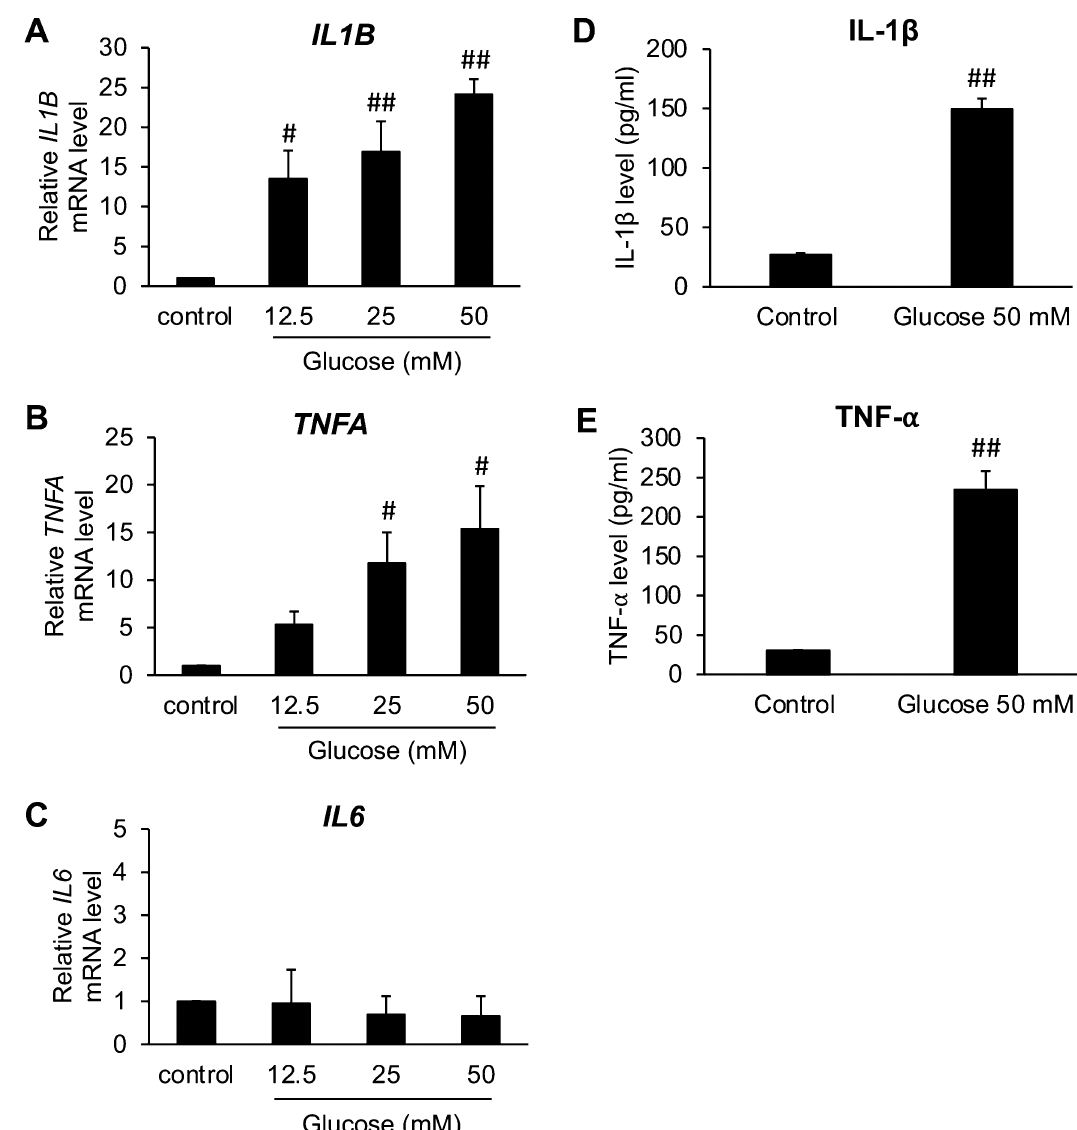
Figure 2. Effects of high glucose on pro-inflammatory cytokines, IL-1β, TNF- ⍺ , and IL6, gene expression ( A ), and secretion ( B ) in BV2 cells. Cells were incubated with either three doses of glucose (12.5, 25, 50 mM) for 24 h or only 50 mM glucose for 48 h. Next, the level of mRNA and protein of these pro-inflammatory cytokines were measured by real time-PCR and ELISA, respectively. The data are displayed as the mean ± SEM from three individual experiments. # P < 0.05 or ## P < 0.01 versus the control